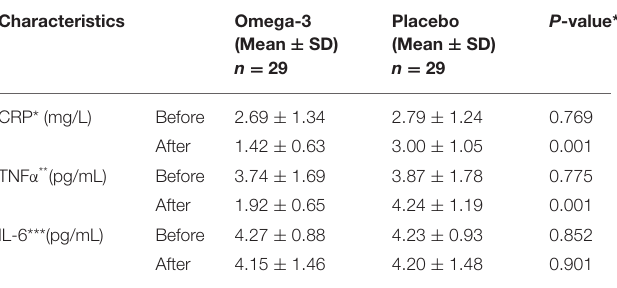
TABLE 4 | Inflammatory markers of patients with lung cancer in omega-3 fatty acid supplementation and placebo groups.